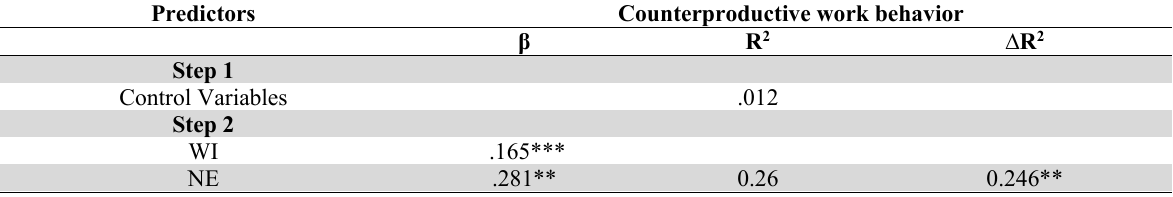
Multiple Regression Analysis Predictors